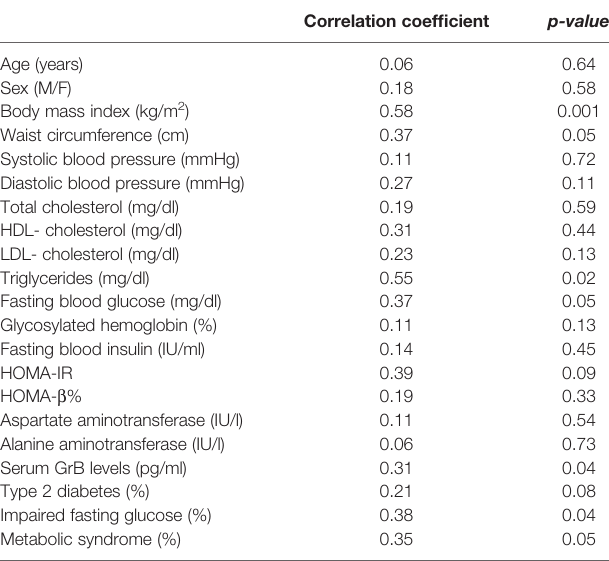
TABLE 5 | Correlation between serum Granzyme B (GrB) levels and clinical and biochemical parameters in obese subjects (n = 85).